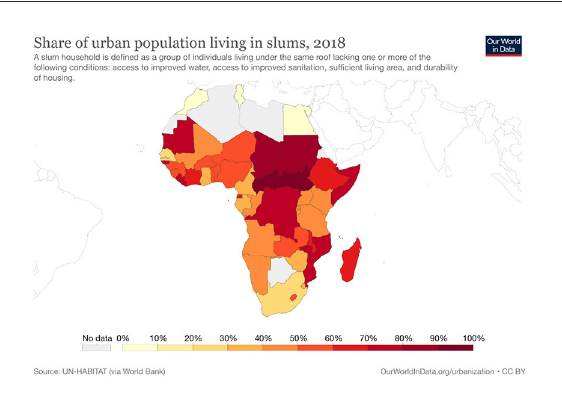
FIGURE2 Share of urban population living in slums, 2018. Source: Ritchie and Roser